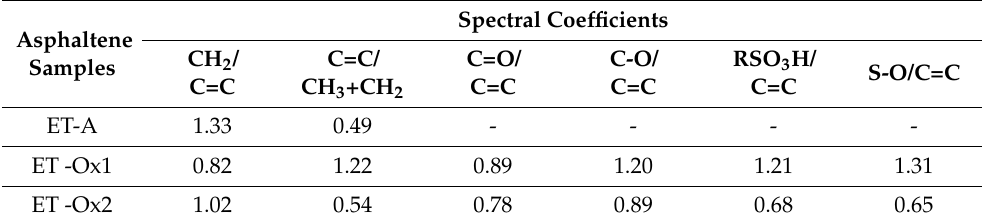
Table 2. Spectral coefficients derived from IR spectroscopy data for